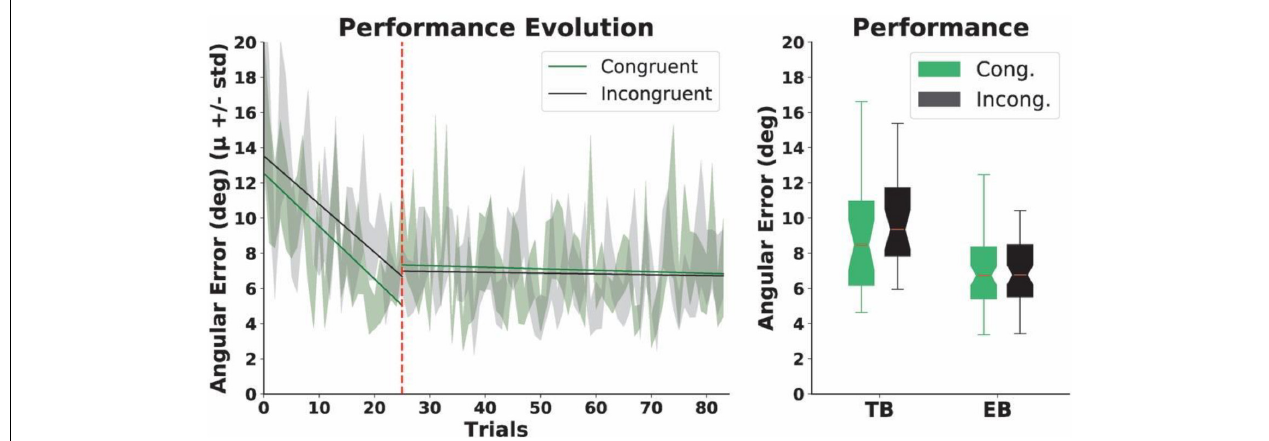
FIGURE 5 | Motor performance. Left: the evolution of angular errors. The dashed red line indicates the end of the Training Block (TB) and the beginning of the Experimental Block (EB). The solid lines represent linear regression models for the angular errors in each condition in the TB and EBs, before or after the dashed red line, respectively. Right: total angular errors. Boxplots represent angular errors for the two conditions in the training and EBs, respectively. No differences were found between the